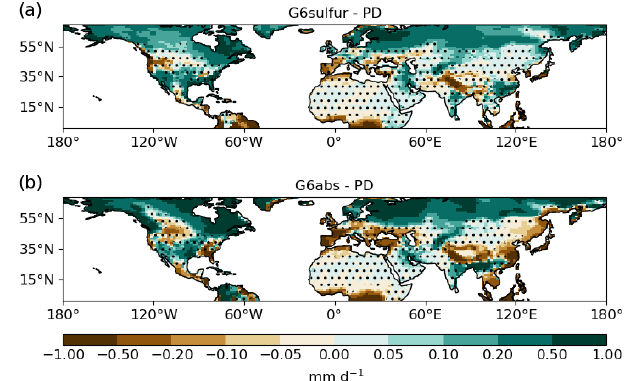
Figure 11. The difference in the DJF land precipitation rates in 2081–2100 compared to the present day for (a) G6sulfur and (b) G6abs. Stippling represents areas that are not significant at the 5% level using a two-tailed t